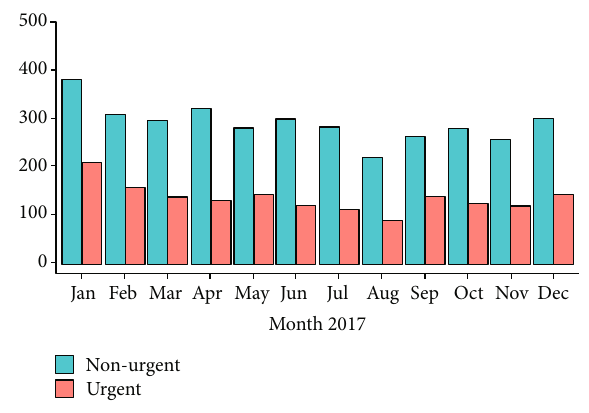
Figure 4: Seasonal comparison between urgent and nonurgent visits in